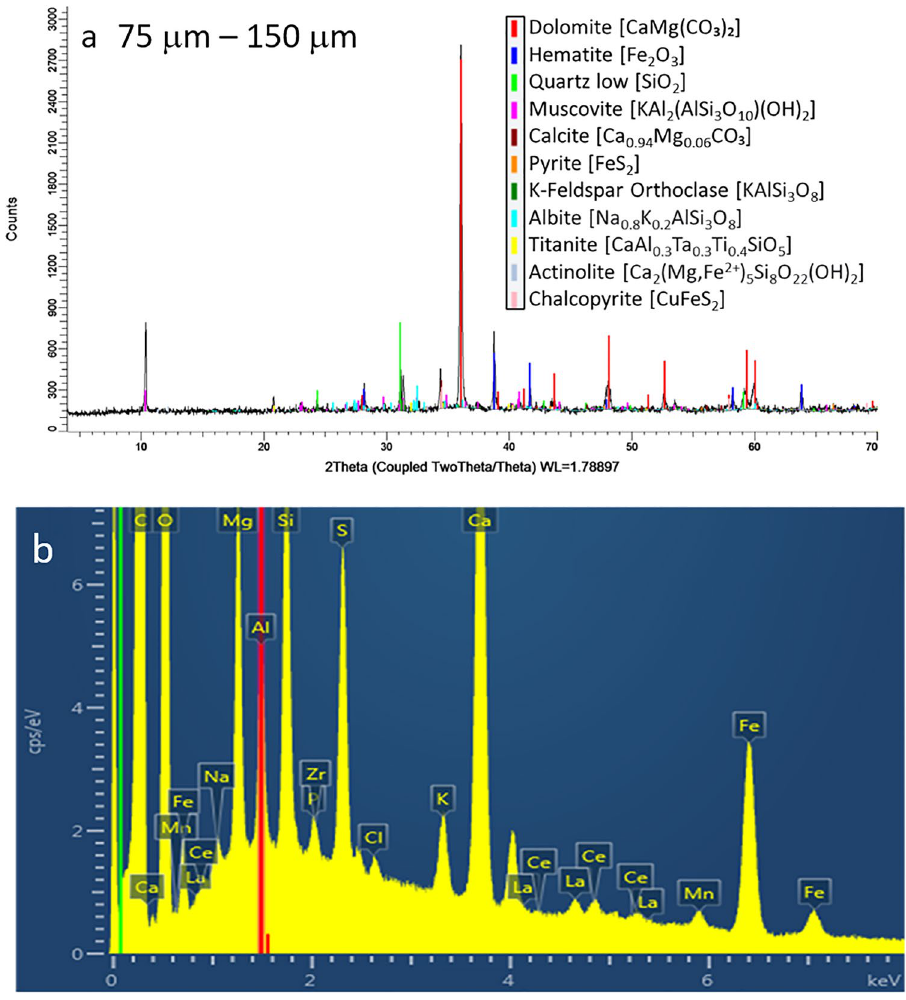
Fig. 3 a XRD pattern of sample PE-02 corresponding to a particles size between 75 and 150 μ m. b Electron dispersive spectroscopy spectra obtained from a region of 200 μ m ×